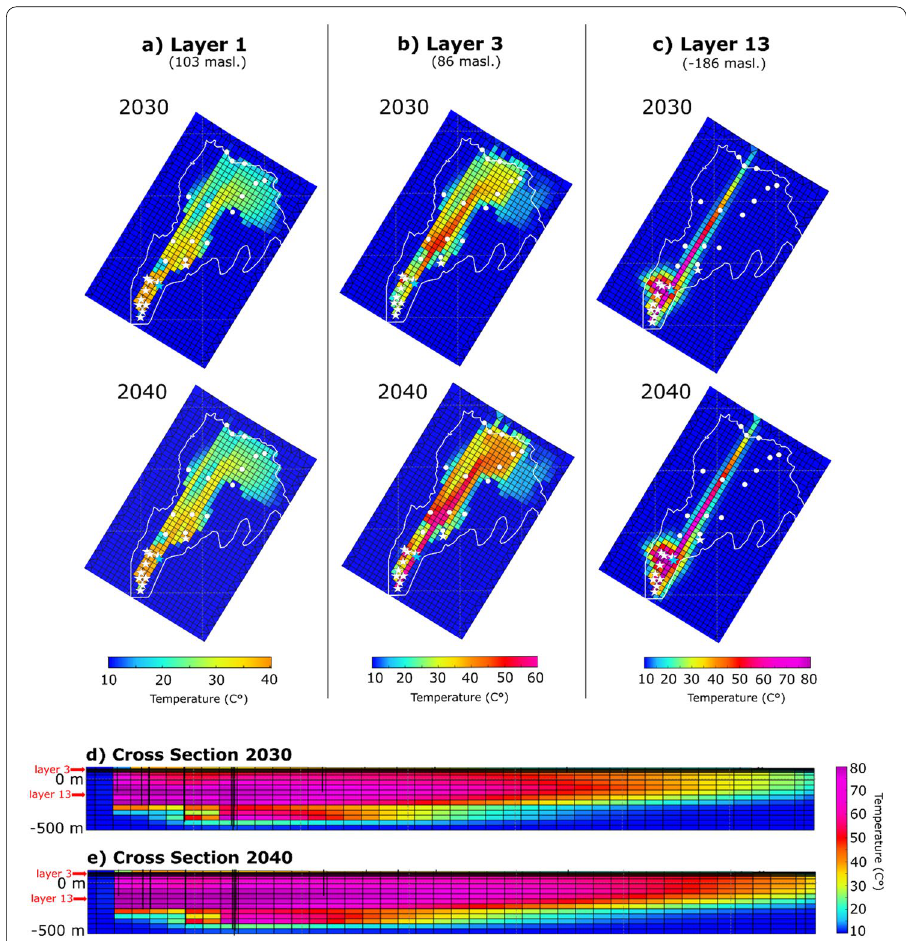
Fig. 18 Evolution of temperature in 2030 and 2040 if injection and production continue at the same average flow rate and temperature from 2018 to 2020 observed in layer 1 ( a ), layer 3 ( b ) and layer 13 ( c ). Cross section along the most permeable fault (FAU10) for 2030 ( e ) and 2040 ( d